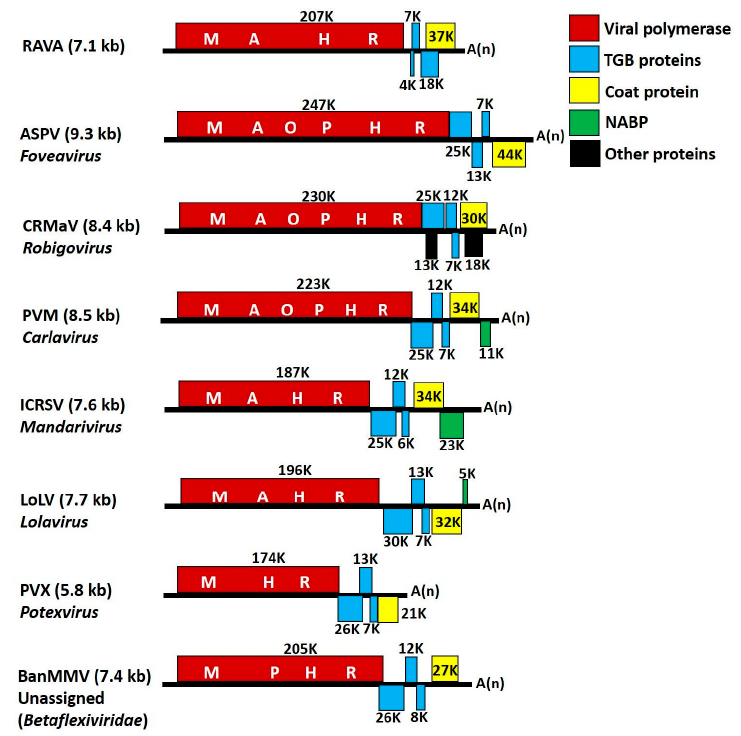
Figure 2. Genome organization of Ribes americanum virus A (RAVA) in comparison to the genomes of members of Tymovirales with triple gene block (TGB) movement proteins.